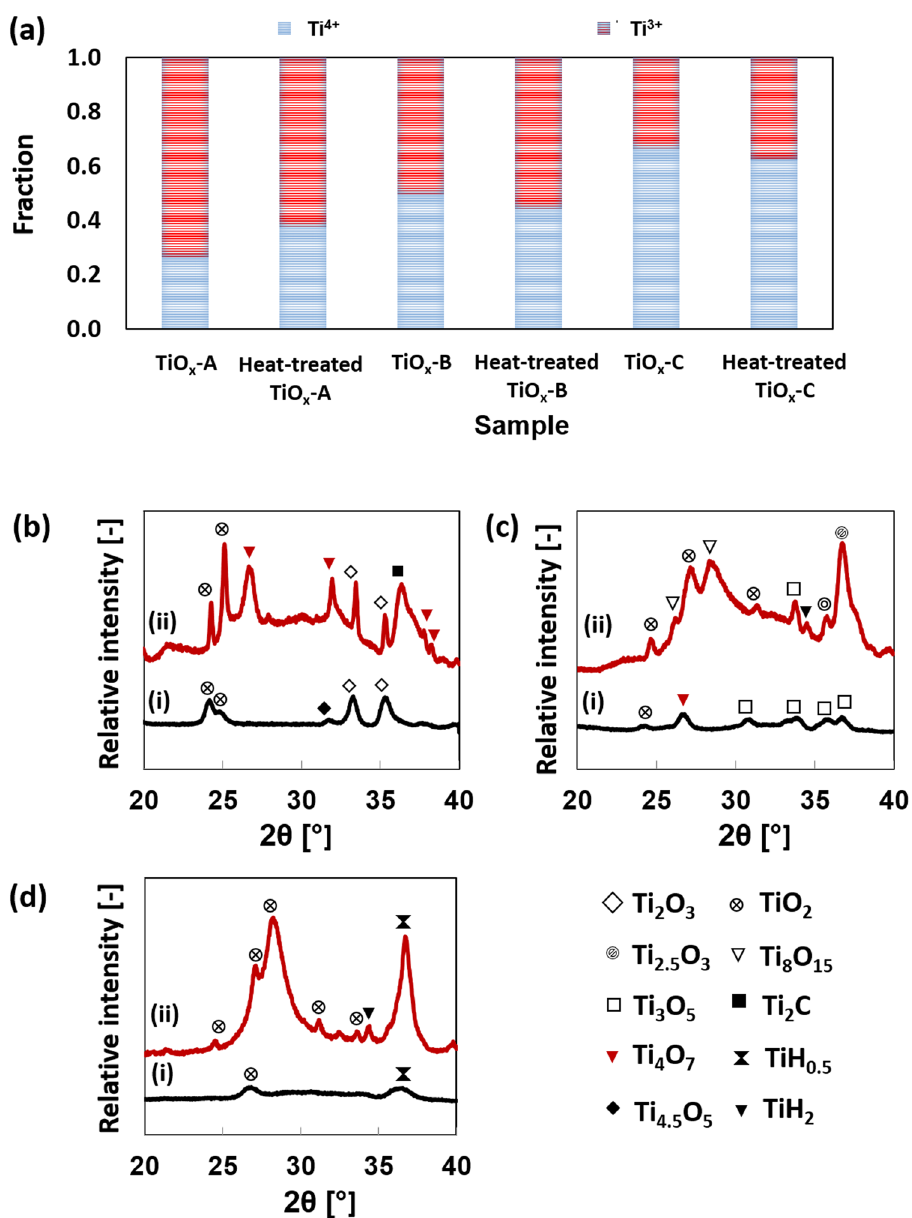
Figure 5. ( a ) Fraction of Ti 3 + and Ti 4 + in the samples based on XAFS analysis. The Magnéli phase composition of each sample was determined based on the XRD spectra of ( b ) TiO x -A, ( c ) TiO x -B, and ( d ) TiO x -C. (i) is the spectra of as-synthesized nanoparticles and (ii) is the spectra of heat-treated nanoparticles.